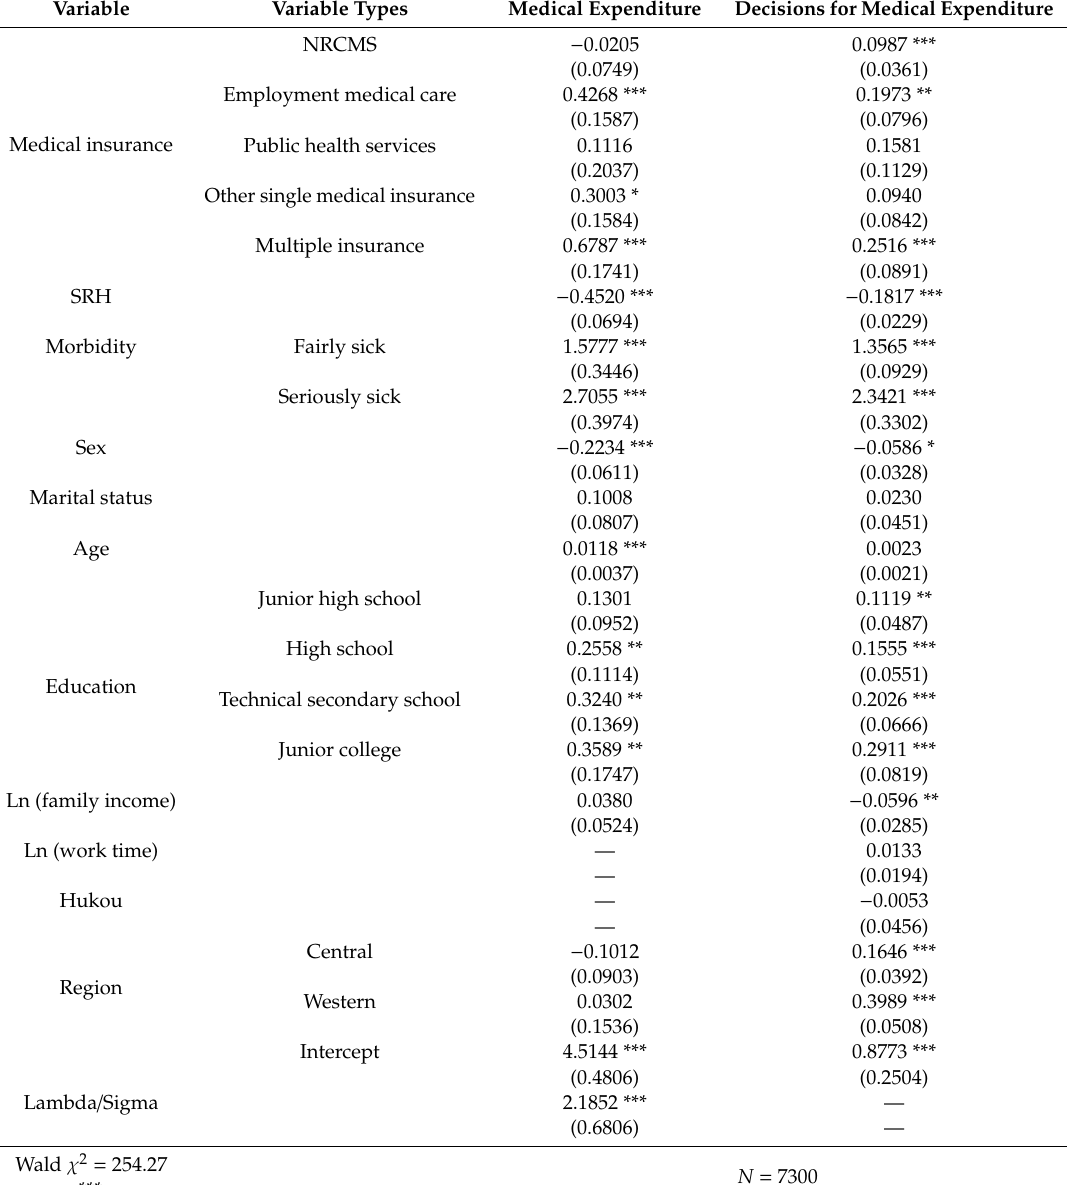
Table 3. Heckman selection model of migrant workers’ medical